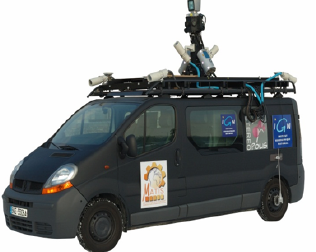
Figure 9 The mobile mapping system of IGN